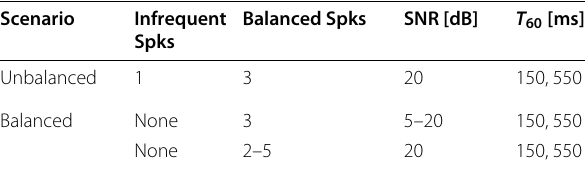
are higher than the scores obtained for the “Max-Corr” method. Both “Simplex-Corr” and “Max-Corr” methods obtain better performance compared to the “Simplex- EVD” method with respect to the infrequent speaker. For this speaker, we observe an advantage of the “Max-Corr” Table 1 Examined